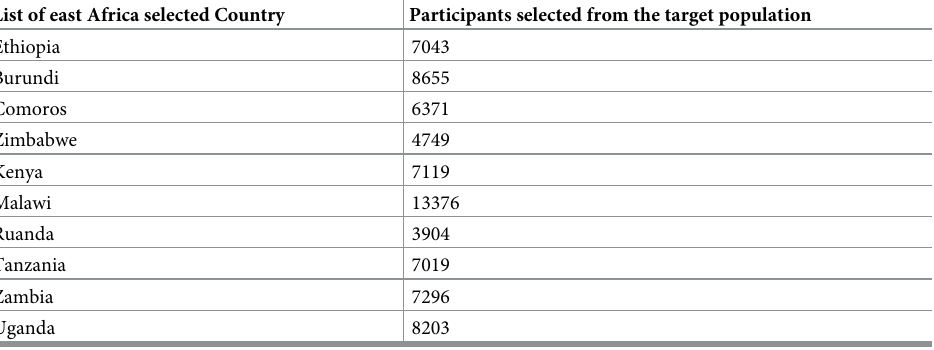
Table 1. Selected number of study participants in the 10 East Africa selected countries’ using the demographic and health surveys 2014–2019. List of east Africa selected